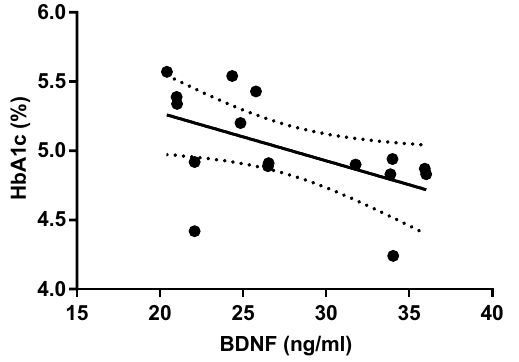
Figure 4. Scatterplot showing Pearson correlation between serum BDNF and HbA1c levels in S-carriers (r = − 0.531, p =